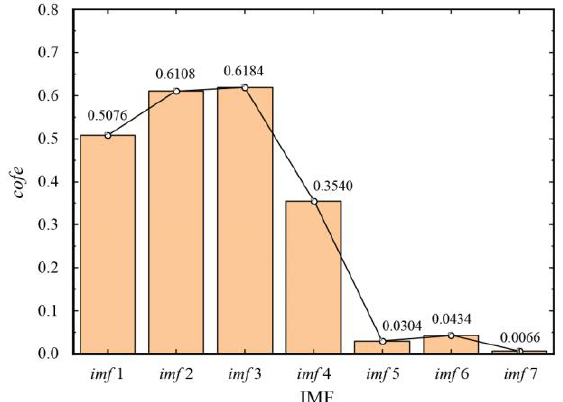
Figure 6. Correlation coefficients of signal and IMF.